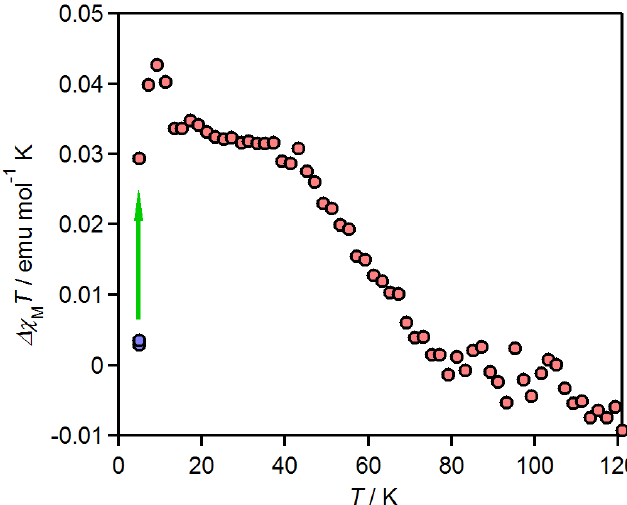
Figure 5. Thermal relaxation of the photo-induced paramagnetism ( Δ χ [Fe(tdap) (NCS) ] [53]. Adapted by permission of The Royal Society of 2 2